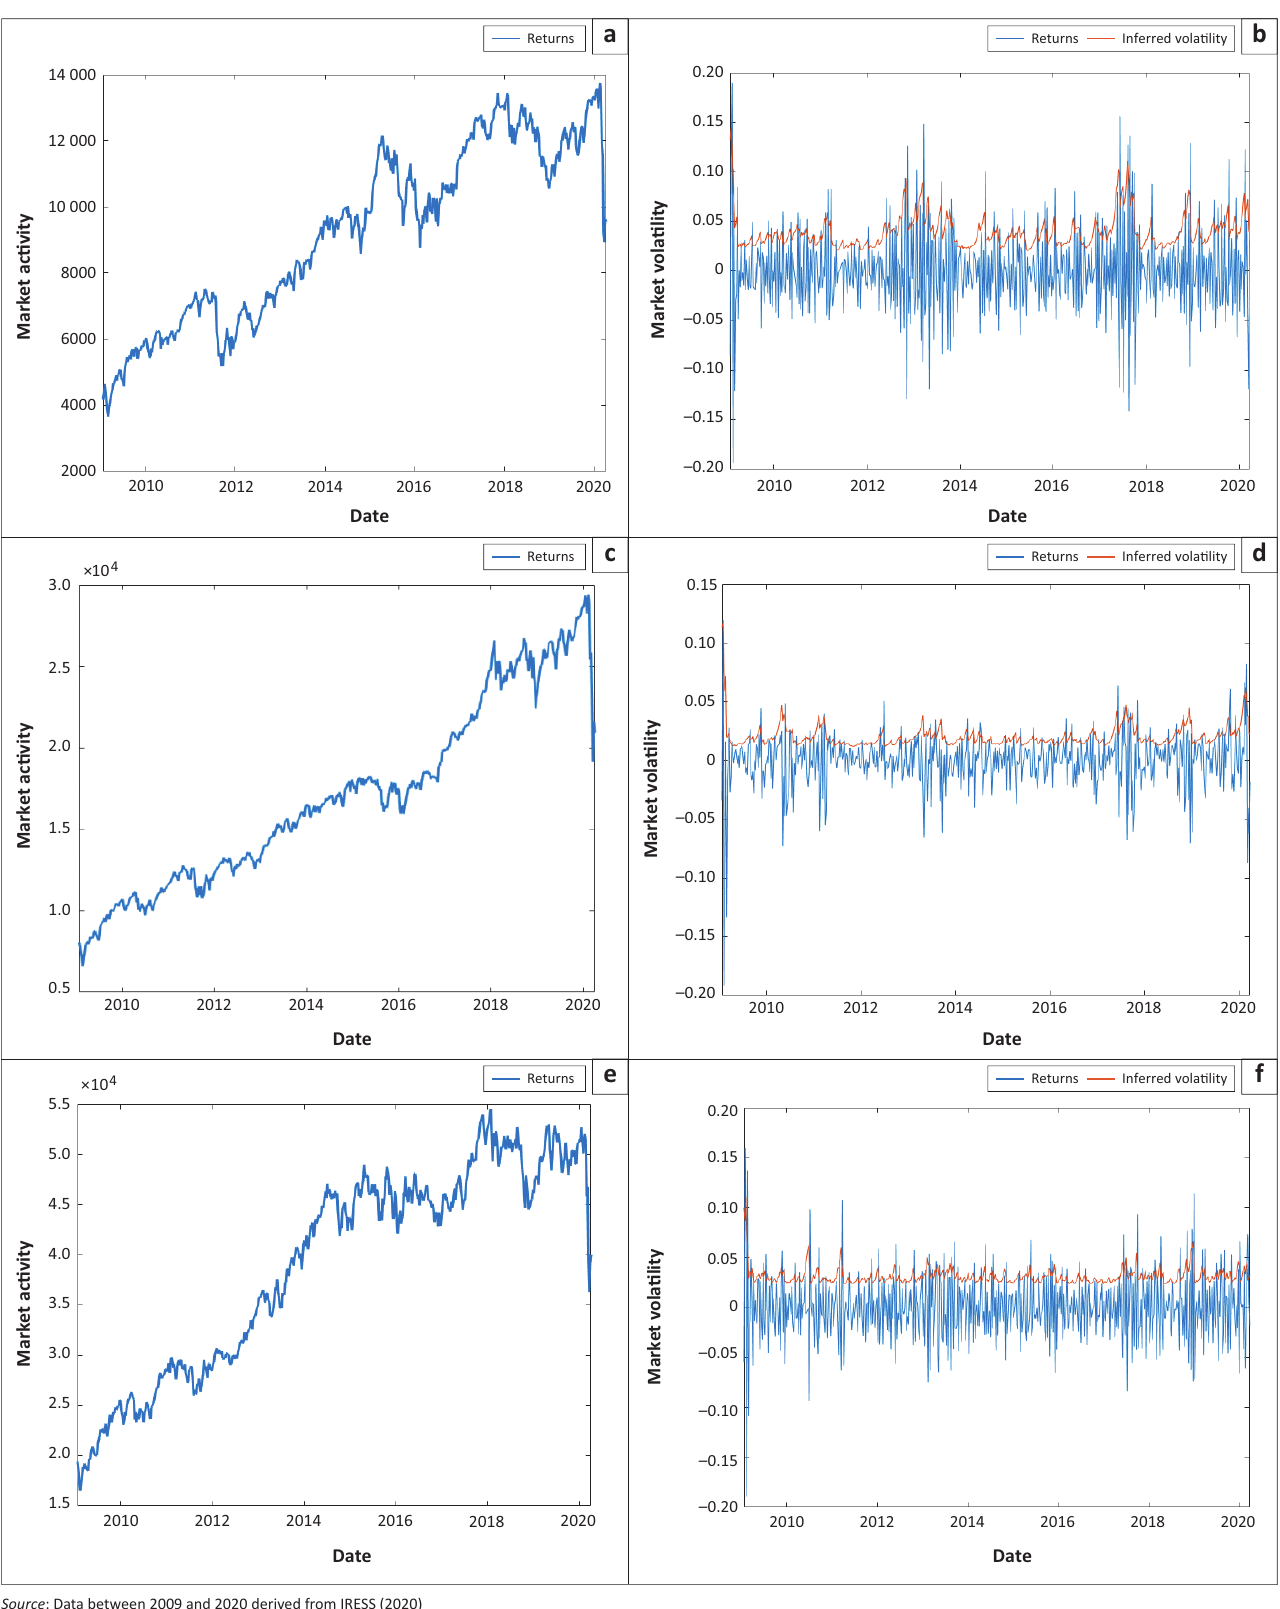
FIGURE 3: Graphical representation of the Dax, Dow Jones Industrial Average, Financial Times Stock Exchange/Johannesburg Stock Exchange All Share, Nikkei 225 and the London Stock Exchange highlighted in column 1 the Market Performance and in column 2, the ‘Returns to Investment’ and ‘Inferred Volatility’ in the market and the impact of COVID-19 on the respective stock market indices. (a) Dax, (b) Returns and inferred volatility, (c) Dow Jones, (d) Returns and inferred volatility, (e) FTSE, (f) Returns and inferred volatility, (g) Nikkei 225, (h) Returns and inferred volatility, (i) LSE, (j) Returns and inferred